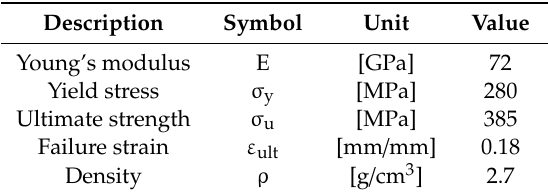
Table 1. Aluminum alloy mechanical properties [20].